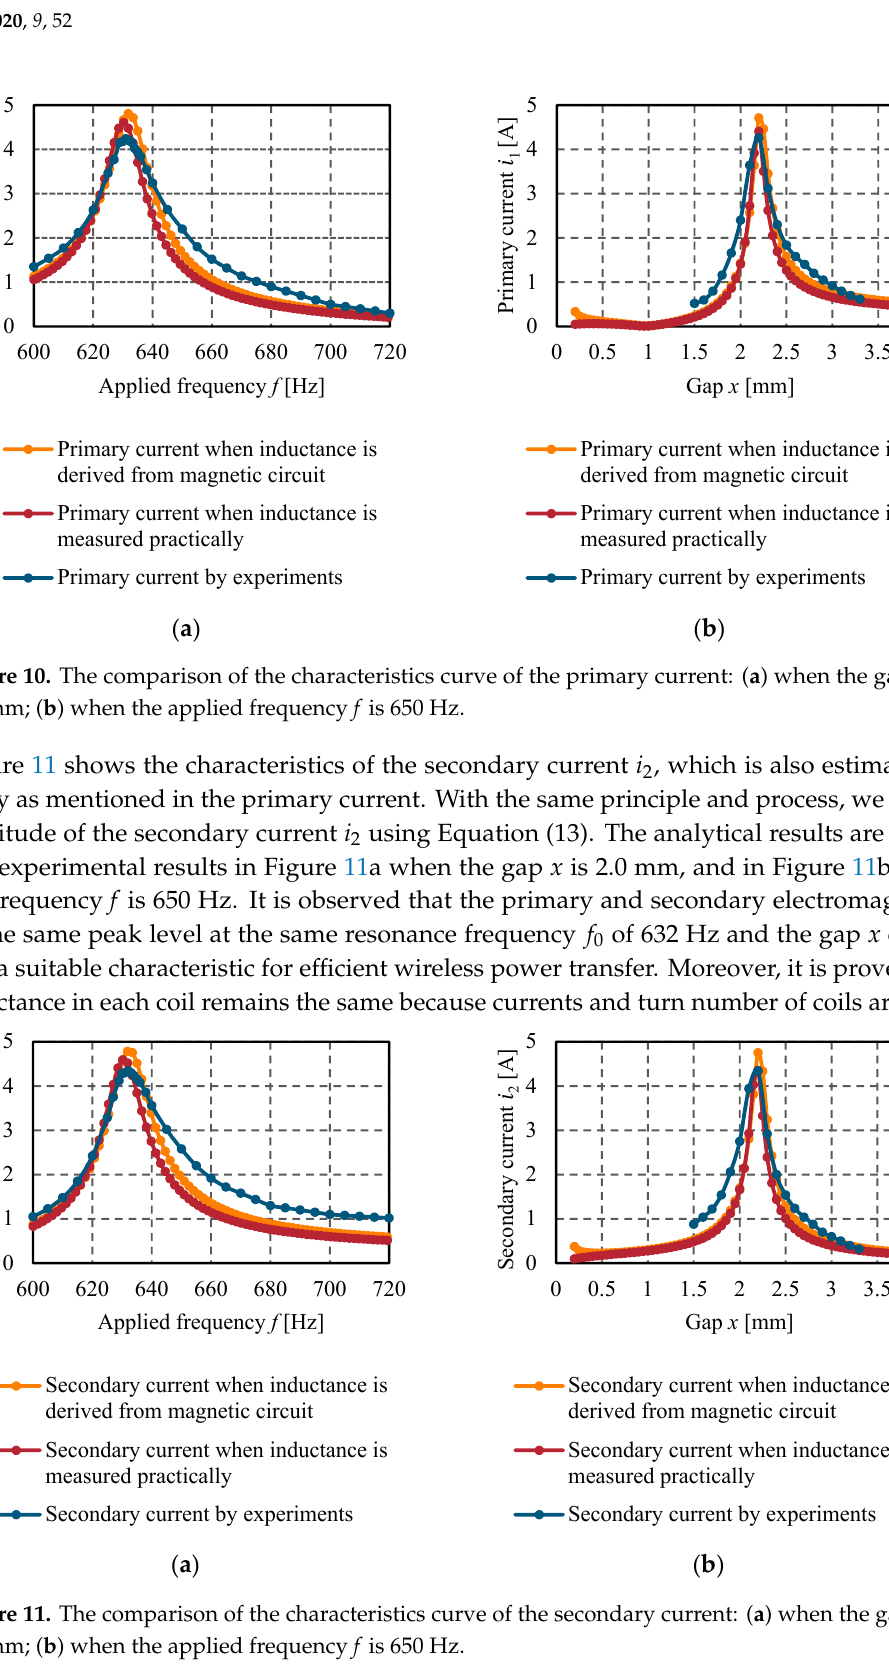
( b ) Figure 12. Characteristics of the phase difference between the primary and secondary currents: ( a ) when the gap x is 2.0 mm; ( b ) when the applied frequency is 650 Hz.